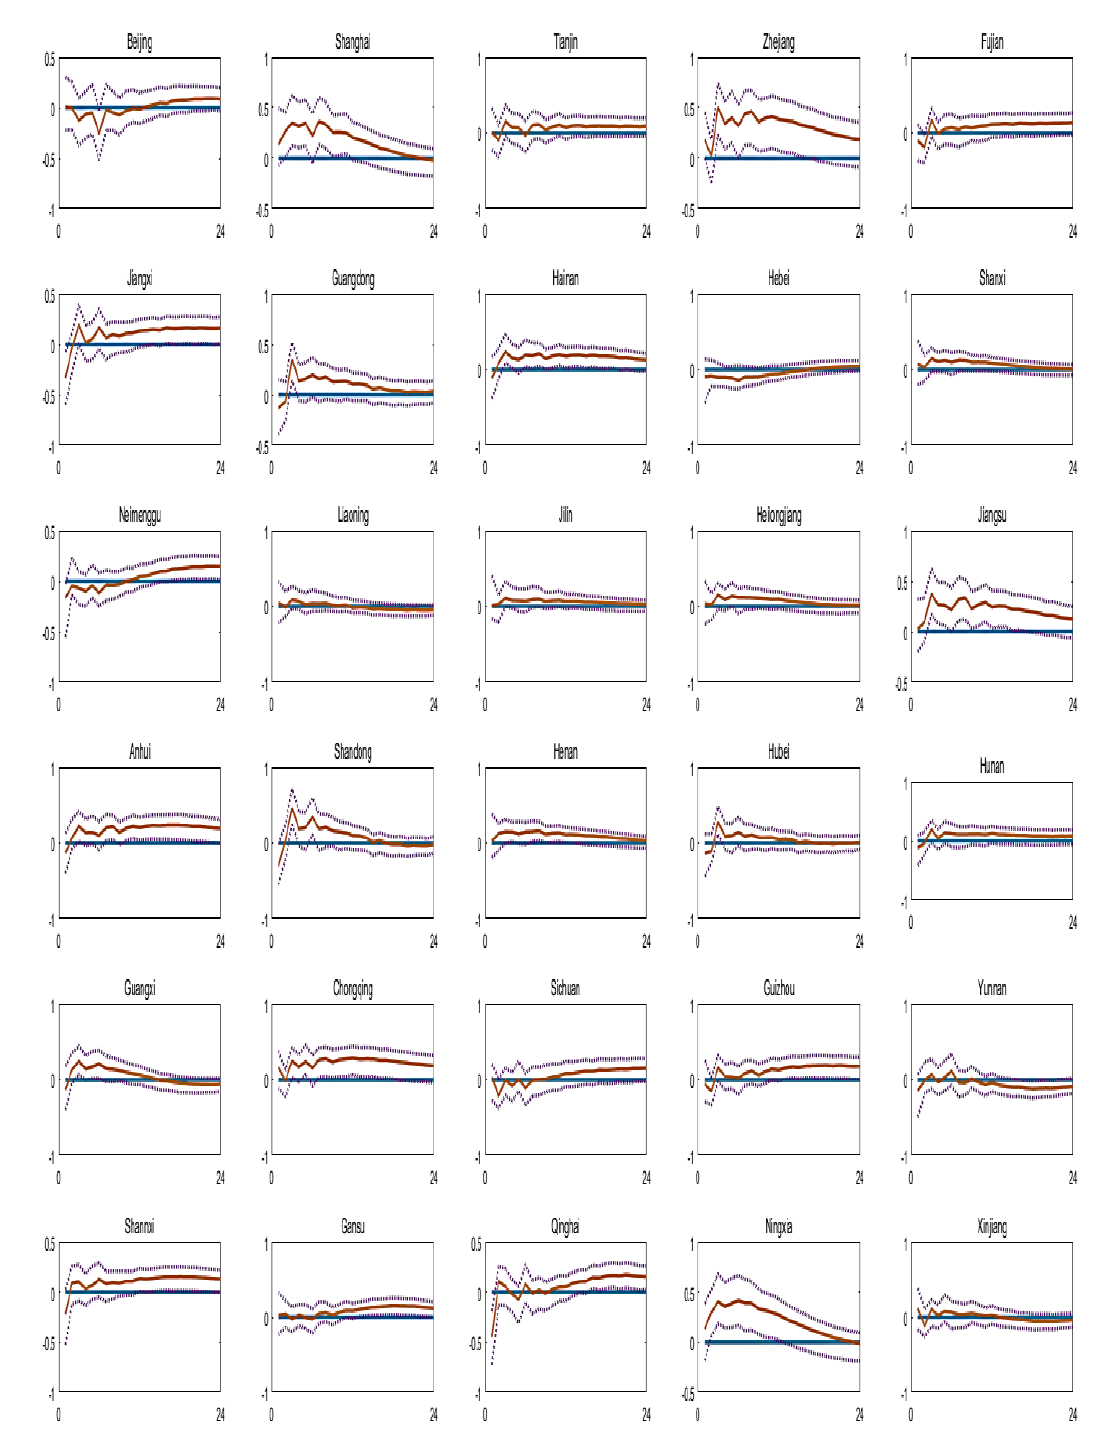
Figure A3. Impulse responses of regional house prices to one standard error shock to real output: FAVAR system with three factors.